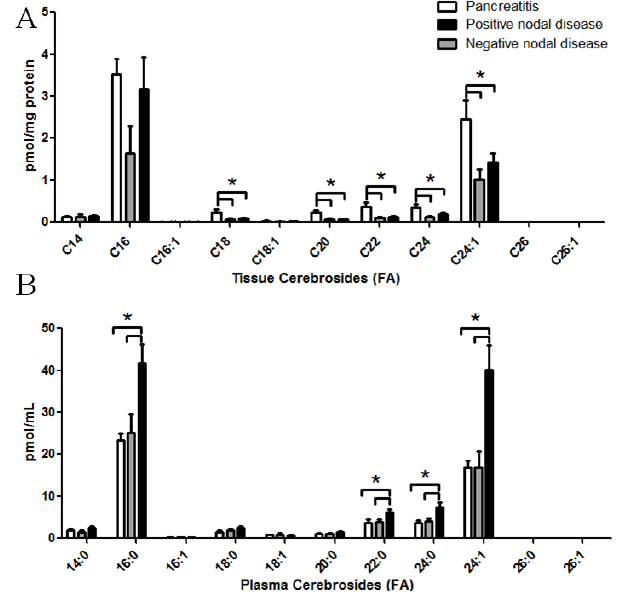
Figure 2. Altered cerebroside levels in patient specimens with pancreatic cancer. LC-MS/MS was utilized to quantify cerebrosides from patient specimens. Cerobrosides with a d18:1 backbone with fatty acids from 14 to 26 carbons were assessed. Molecular species of cerebrosides were quantified from pancreas tissues ( A ); and corresponding plasma samples ( B ) from patients with pancreatitis, non-metastatic (nodal negative) pancreatic cancer, or metastatic (nodal positive) pancreatic cancer. * p < 0.05 assessed by t -test